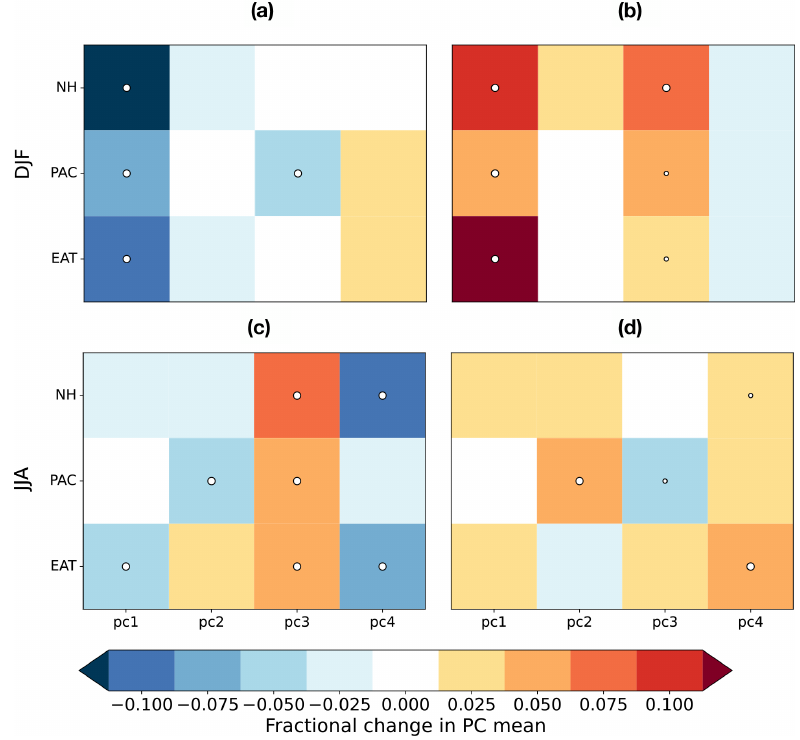
Figure B1. Fractional change (relative to climatological standard deviation) of the PC mean for the first four leading EOFs, as functions of the region of interest, for (a) DJF poleward extremes, (b) DJF equatorward extremes, (c) JJA poleward extremes and (d) JJA equatorward ex- tremes. White dots denote the significance of the change with respect to the overall population of events. Large dots denote 99% significance, and small dots denote 95% significance.